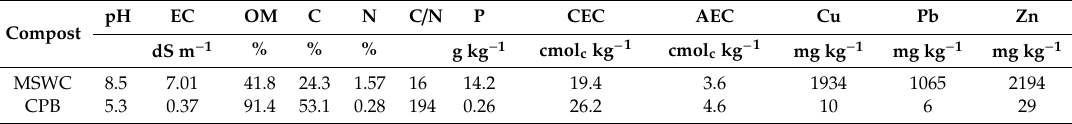
Table 1. Composts properties. EC: electric conductivity; OM: total organic matter; CEC: cation exchange capacity; AEC: anion exchange